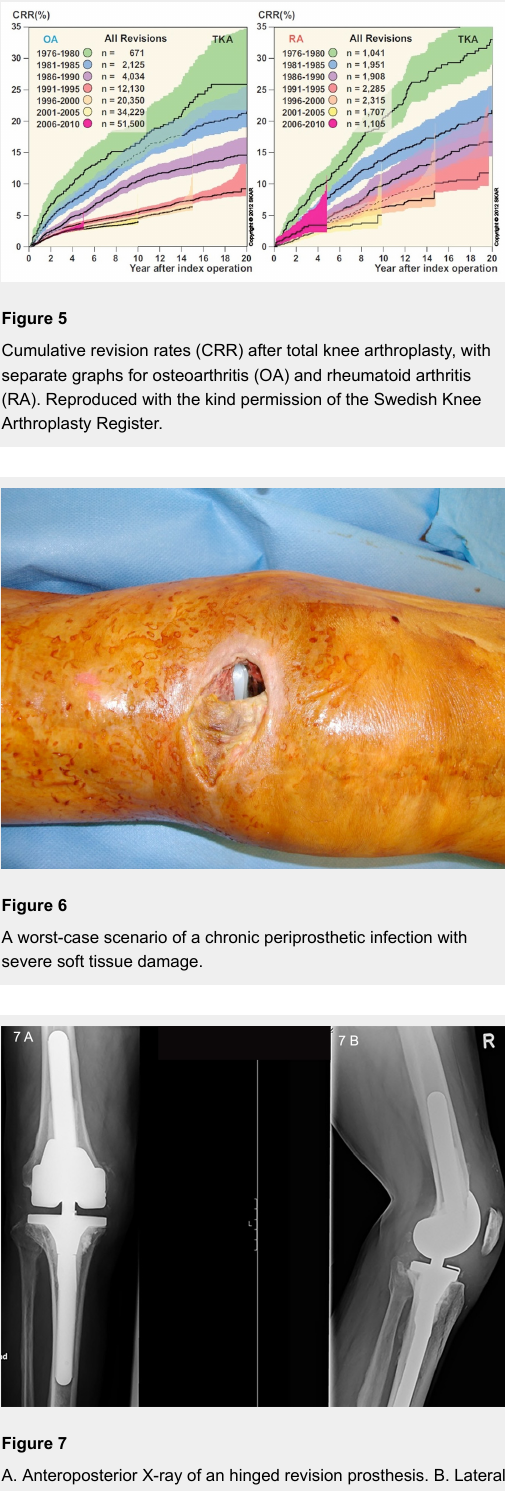
A. Anteroposterior X-ray of an hinged revision prosthesis. B. Lateral view in the same